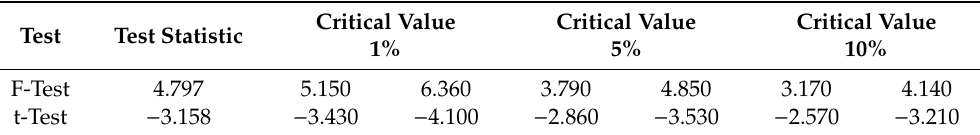
Table A9. Bound test.